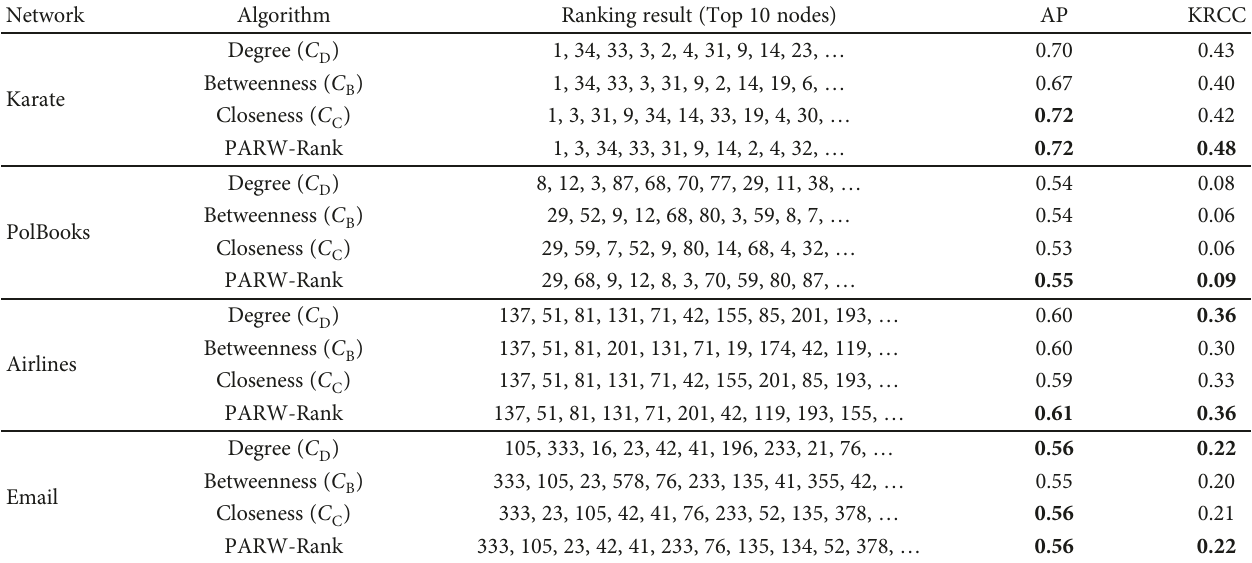
Table 6: The ranking results and precisions for other four